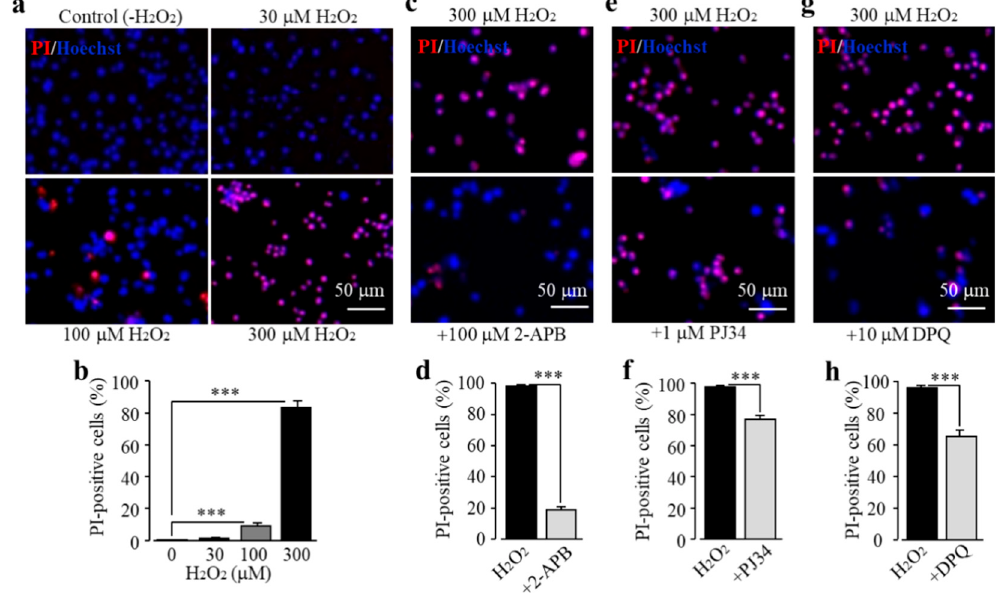
Figure 2. Reactive oxygen species (ROS) induce BV2 microglial cell death via poly(ADP-ribose) polymerase (PARP)-dependent TRPM2 channel activation. ( a , b ) Representative fluorescent images showing co-staining with propidium iodide (PI) and Hoechst ( a ) and mean percentage of PI-positive cells ( b ) in cells without (control) and with exposure to indicated concentrations of H 2 O 2 for 24